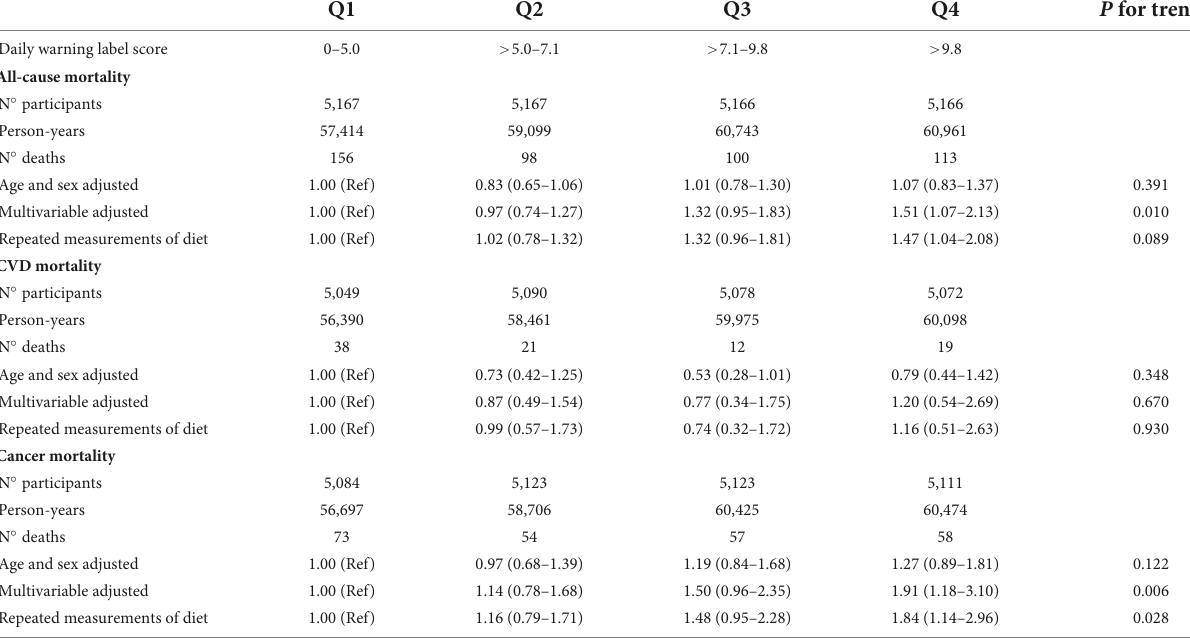
TABLE 2 Cox proportional hazard ratios (95% confidence intervals) for mortality according to quartiles of Chilean warning label score. Q1